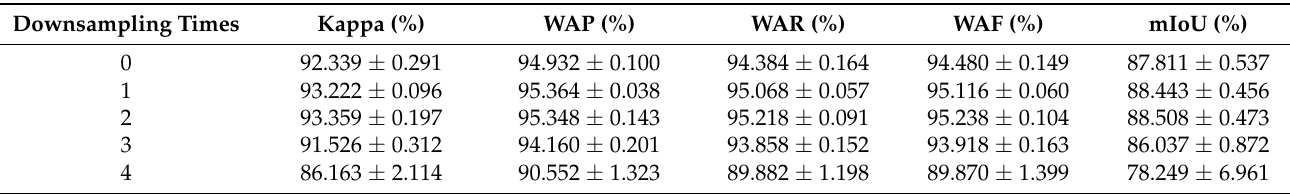
Table 5. Comparison of performance with different downsampling times.